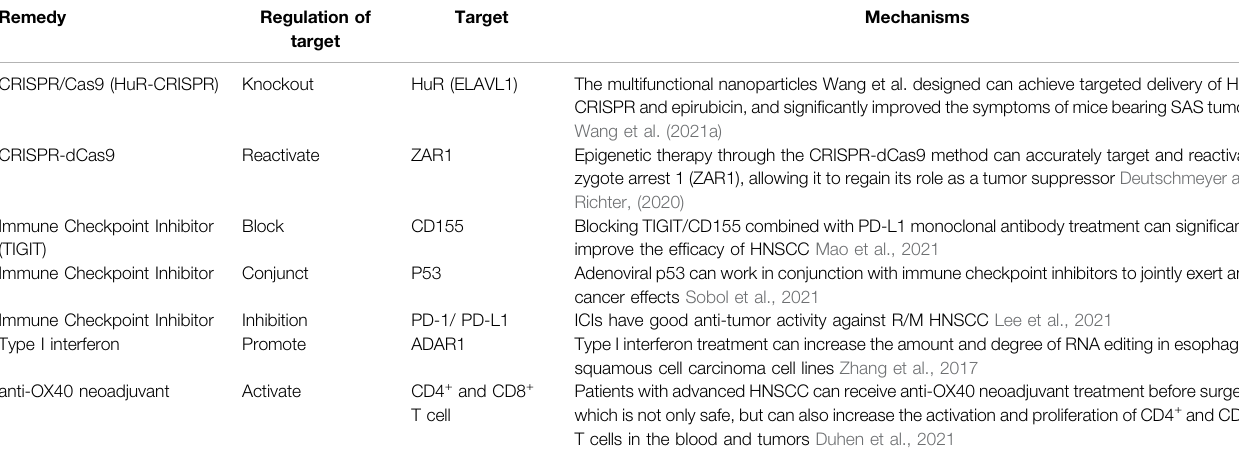
TABLE 2 | Immunotherapeutic methods and targets of